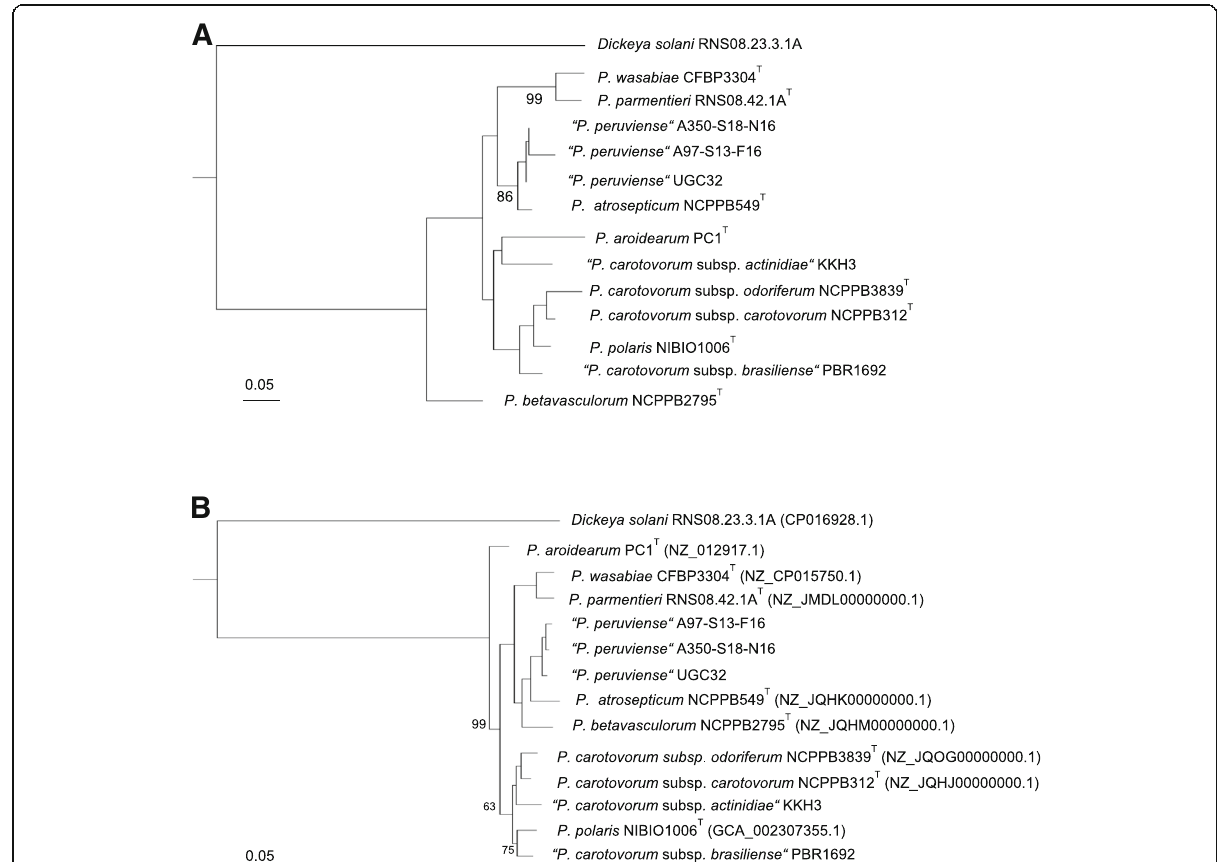
Fig. 2 Phylogenetic trees of “ P. peruviense ” strains and strains of other Pectobacterium species and subspecies. a Phylogenetic tree constructed from the gap A nucleotide sequences. Sequences were aligned using the MUSCLE software [24] and the alignments were filtered by using the program GBLOCKS [25].Tree was computed using PHYML [26]. One hundred bootstrap replicates were performed to assess the statistical support of each node. Bootstrap support values (percentages) are indicated if superior to 95%. gap A sequences were retrieved from full genome of type strains (accession numbers are indicated in Fig. 1b) or obtained from the sequenced gap A amplicon for strains A97-S13-F16 and A350-S18-N16. b Phylogenetic tree constructed from concatenated sequences of 1266 homologous amino acid sequences. Before concatenation, the homologous sequences of each gene were aligned using the MUSCLE software [24] and the alignments were filtered by using the program GBLOCKS [25]. Tree was computed using PHYML [26]. One hundred bootstrap replicates were performed to assess the statistical support of each node. Bootstrap support values (percentages) are shown if less than 100%. The accession number for each genome is indicated inside brackets after the strain name. Dickeya solani RNS08.23.3.1.A was used as outgroup. Type strains are marked with T after the strain